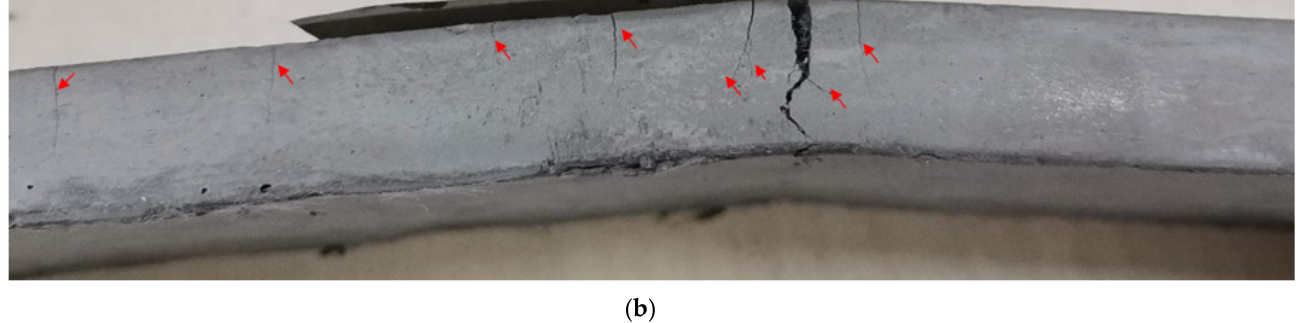
Figure 4. The specimens were subjected to the flexural strength test. ( a ) 0 NCa; ( b ) 1 NCa.